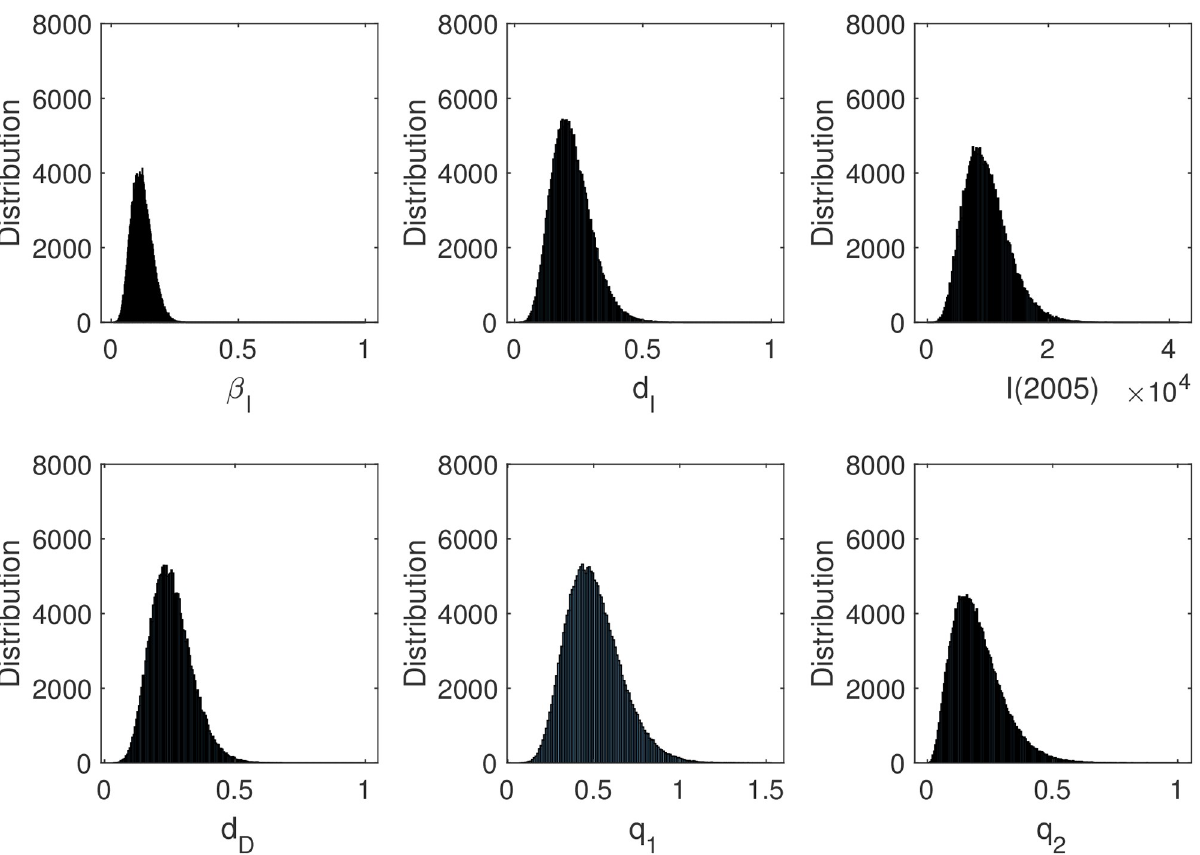
Fig 10. Histogram of parameters. Through Metropolis-Hastings algorithm, the histogram of different parameters is obtained, that is, the distribution of different parameters. The 95% confidence interval of each parameter can be approximately obtained by parameter distribution.